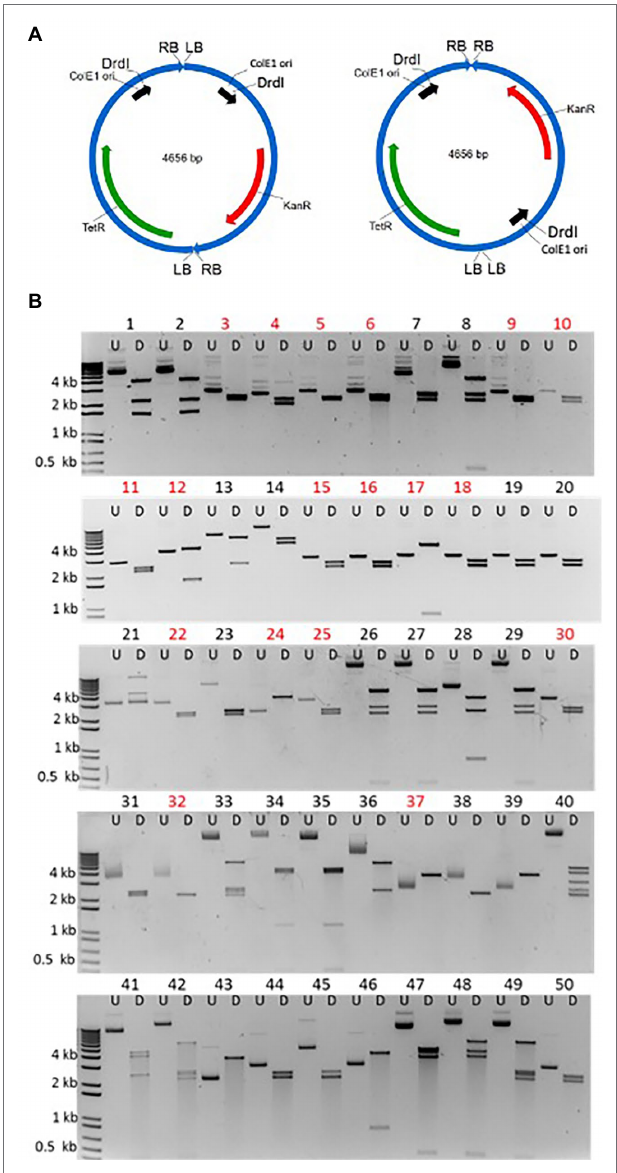
FIGURE 3 | Characterization of T-circles composed of two different T-DNAs. (A) Two T-DNAs can end-join to each other in either of two configurations: “Head-to-tail” that will produce 3.9 and 0.7 kbp Drd I fragments (left) or “head- to-head” and “tail-to-tail” that will produce 2.2 and 2.4 kbp Drd I fragments (right). (B) 50 T-circles conferring resistance to both kanamycin and tetracycline following co-agroinfiltration with Agrobacterium tumefaciens EHA105 containing the KAN-ORI and TET-ORI T-DNA binary vectors. Each plasmid is shown undigested (U) and Drd I digested (D). Eighteen unique sequenced T-circles are marked in red (T-circles #19, #20, #32, #38, #39, #43, #44, and #50 are